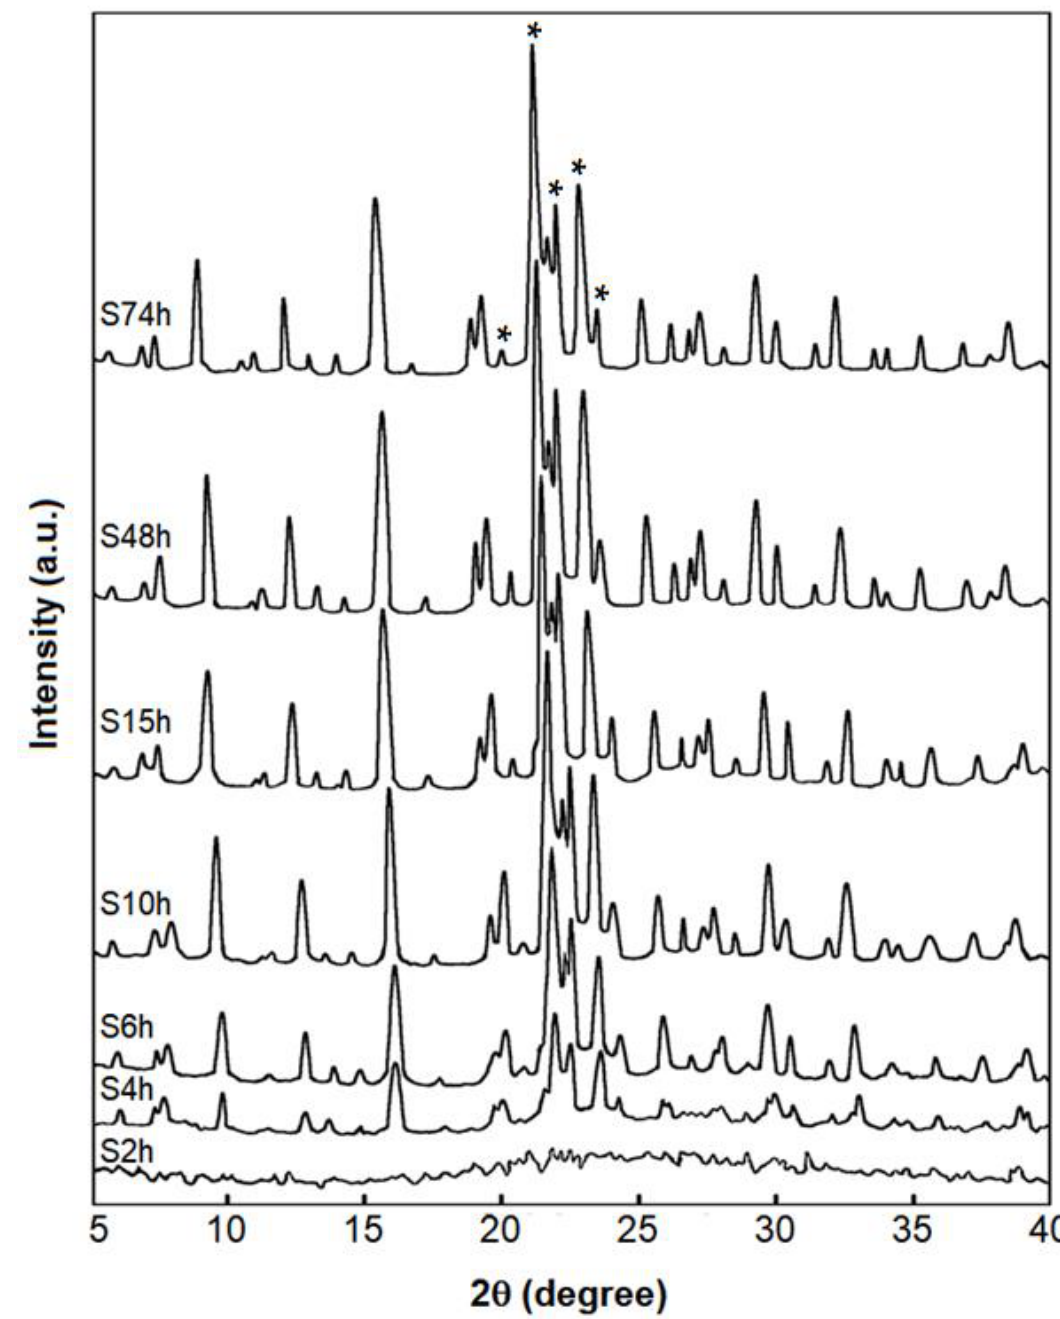
Figure 3. XRD pattern of the samples obtained during the crystallization process of AlPO 4 -11, monitored at different times. The peaks labeled with (*) were used for determination of the crys- tallinity.